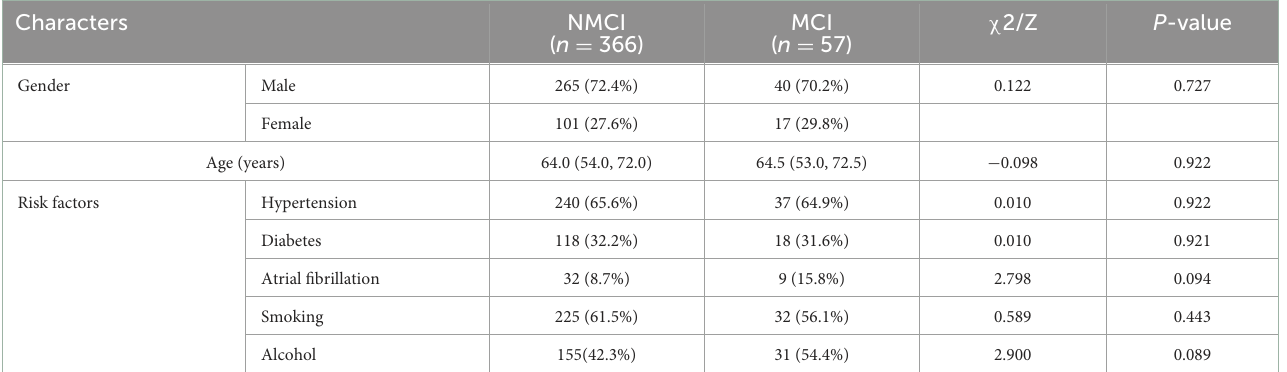
TABLE 1 Comparison of baseline data between the MCI group and the NMCI group.